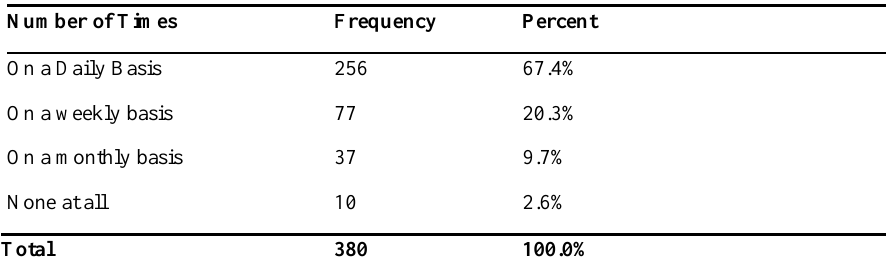
Table 2: Distribution of Respondents based on Inability to Access Health Care